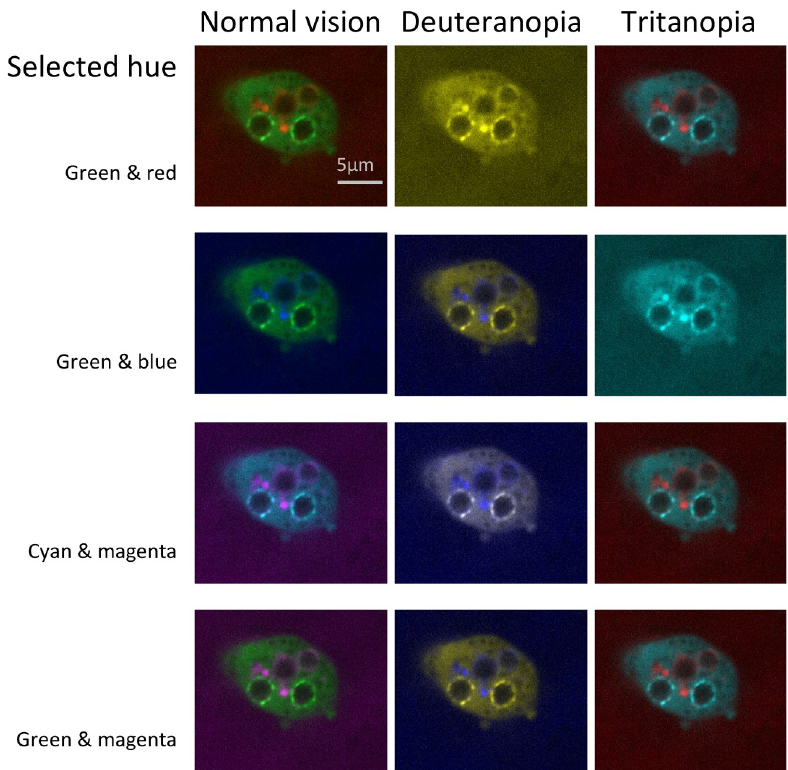
Fig 7. Color combinations as seen with normal vision and 2 types of colorblindness. The figure illustrates how 4 possible color combinations for multichannel microscope images would appear to someone with normal color vision, the most common form of colorblindness (deuteranopia), and a rare form of color blindness (tritanopia). Some combinations that are accessible to someone with deuteranopia are not accessible to readers with tritanopia, for example, green/blue combinations. Microscope images show Dictyostelium discoideum expressing Vps32-GFP (Vps32-green fluorescent protein shows broad signal in cells) and stained with dextran (spotted signal) after infection with conidia of Aspergillus fumigatus . All images have the same scale. GFP, green fluorescent